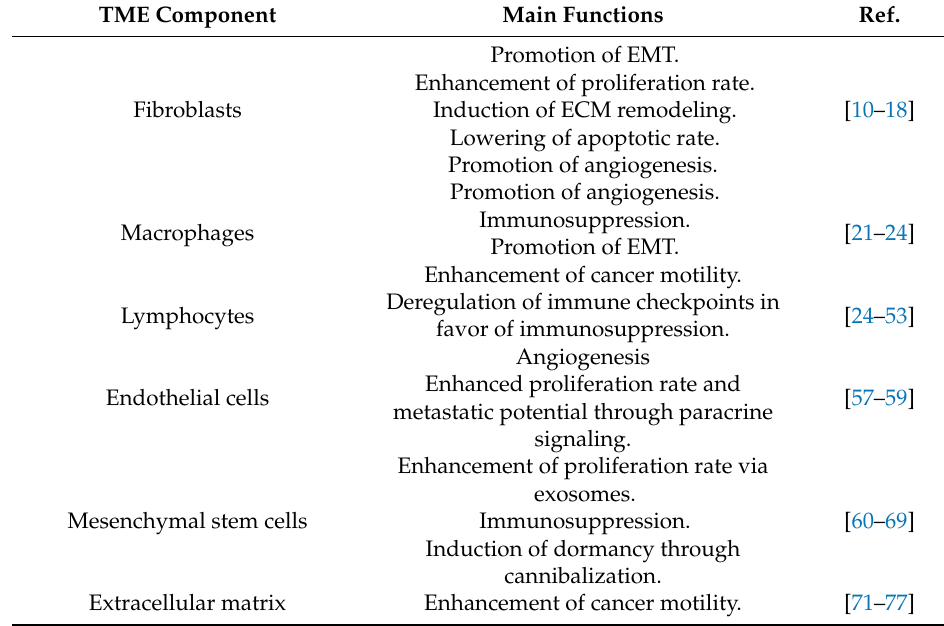
Table 1. Here we have a summary of the above-discussed components of the TME with their main pro-tumoral functions. TME Component Main Functions Ref. Promotion of EMT. Enhancement of proliferation rate. Induction of ECM remodeling. Fibroblasts Lowering of apoptotic